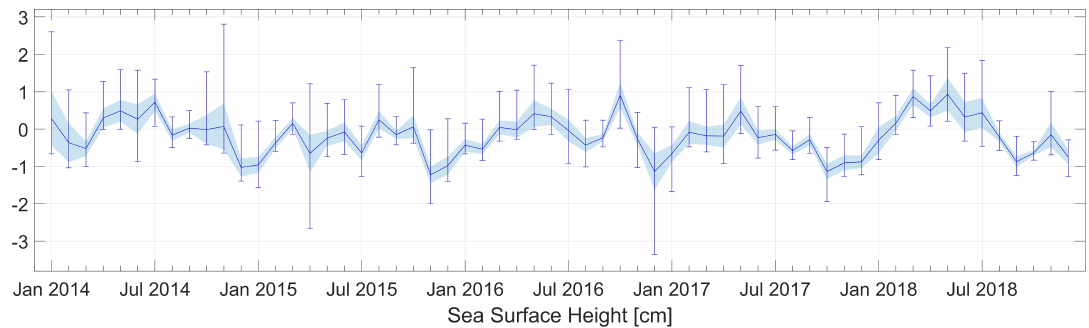
Figure 11. Monthly means of sea surface height for whole domain. Error bars represent minimum and maximum values. Solid line connects monthly means and shadow area shows standard deviation from the mean values.